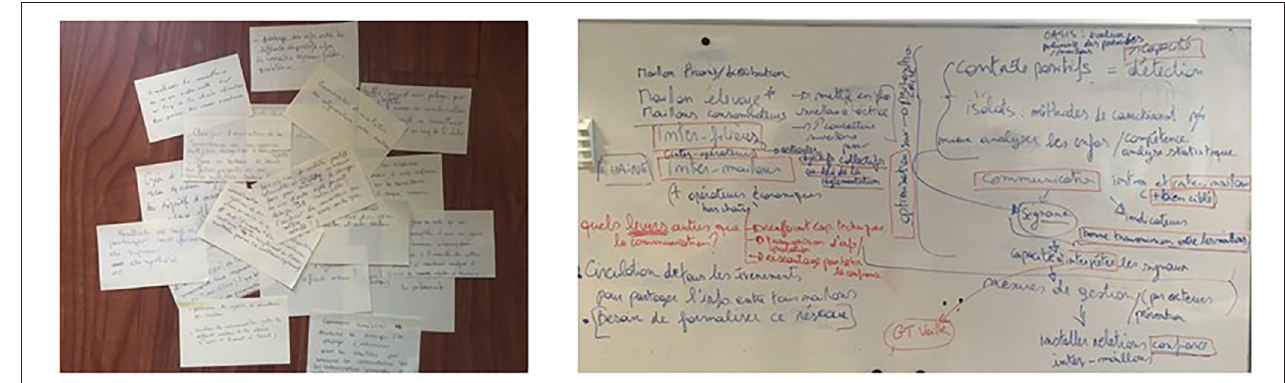
FIGURE 2 | Expectations individually expressed by participants (left) and thematic analysis and coding to define the common problem to address (right) during the workshops in